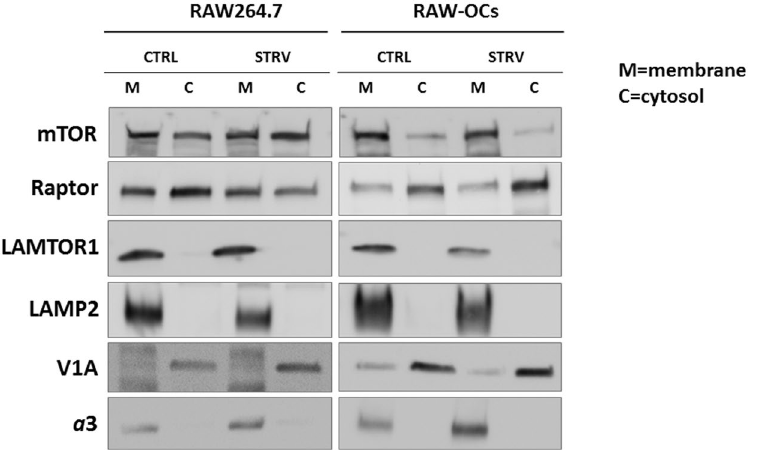
Figure 5. mTOR is primarily membrane-associated in osteoclasts. RAW264.7 cells and RAW-derived osteoclasts (RAW-OCs) were cultured and cytosolic and membrane fractions were prepared as described in “Materials and Methods”. Equal protein amounts were separated on 4–20% gradient gels, transferred to a nitrocellulose membrane and probed for mTOR, Raptor, LAMTOR1, LAMP2, a 3, and V1A. Representative cropped blots of 4 independent experiments. M = membrane fraction; C = cytosolic fraction; CTRL = control, no treatment; STRV = starvation, HBSS, 1